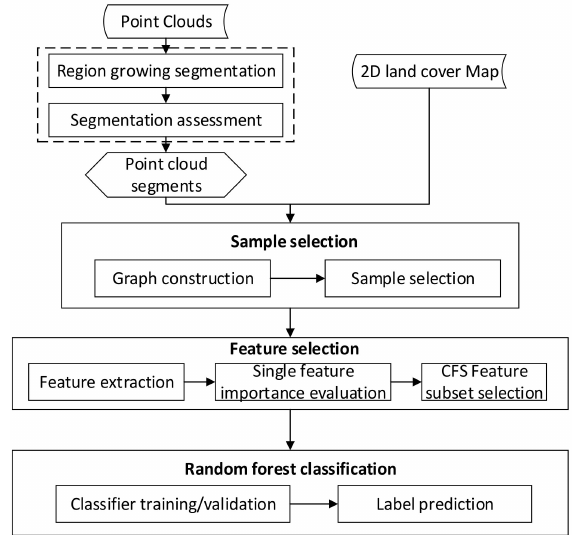
Figure 1. The main flowchart for the proposed approach of point cloud classification. Taking point clouds and the two-dimensional (2D) land cover map as input, the framework includes steps of point cloud segmentation, sample selection, feature selection, and random forest